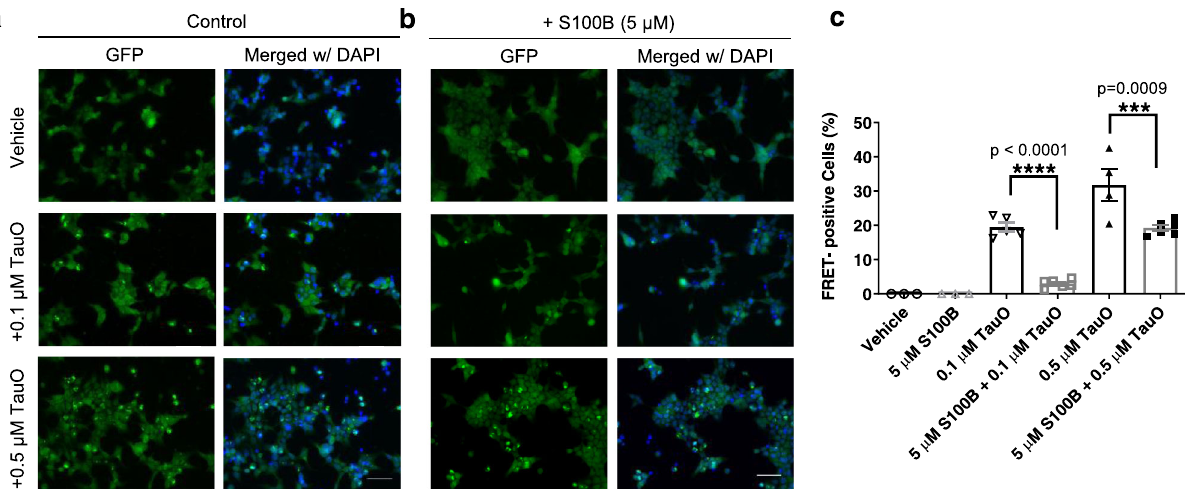
Fig. 6 S100B inhibits toxic seeding mediated by tau oligomers. a , b Representative immuno fl uorescence images of tau RD P301S FRET biosensor cells exposed to tau oligomers (0.1 µ M and 0.5 µ M) alone ( a ) or to tau oligomers preincubated with S100B (5 µ M) ( b ) for 24 h in the presence of lipofectamine. In all, 5 µ M S100B data are shown as representative data of the effect of S100B alone in tau biosensor cells, as even higher concentrations did not cause seeding. Cell nuclei stained with DAPI (blue). Objective used: 40X; scale bar 50 μ m. c Statistical analysis with data presented as mean and standard error of mean from n ≥ 3 independent experimental replicates using one-way analysis of variance (ANOVA) with Tukey ’ s multiple-comparison test. Speci fi cally, for assays with vehicle and 5 µ M S100B n = 3, for assays with 0.1 µ M TauO n = 5, for assays with 0.5 µ M TauO n = 4, and for assays with 5 µ